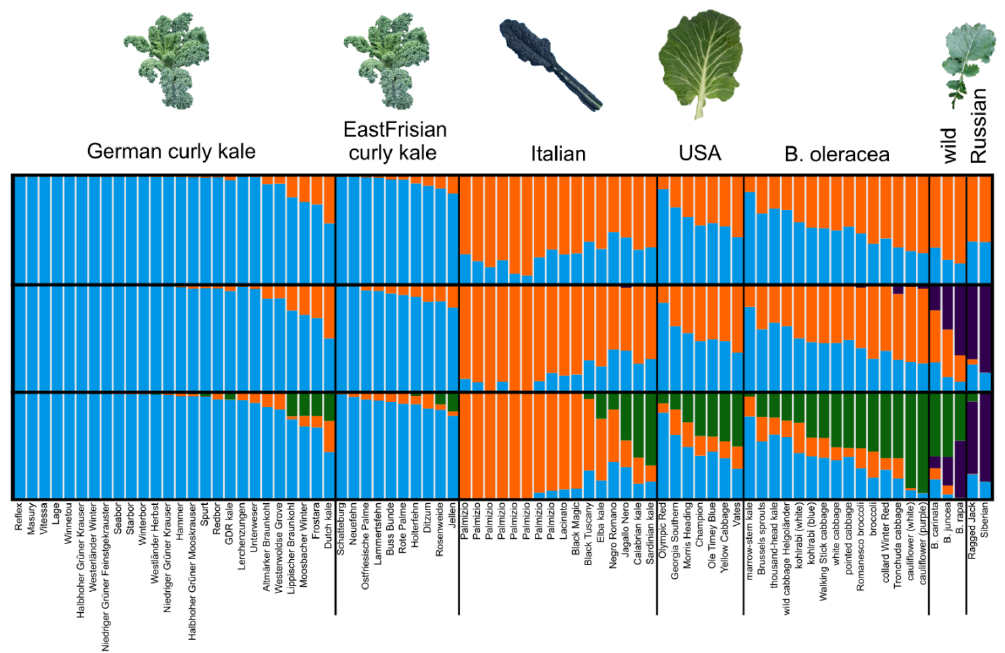
Figure 4. STRUCTURE plot for kale and cabbage varieties from different origins for K = 2–4, based on the SNP data from the filtered dataset. Each column represents one variety, colors indicate the proportion of membership to different clusters. Each figure is a combination of 20 replicates.